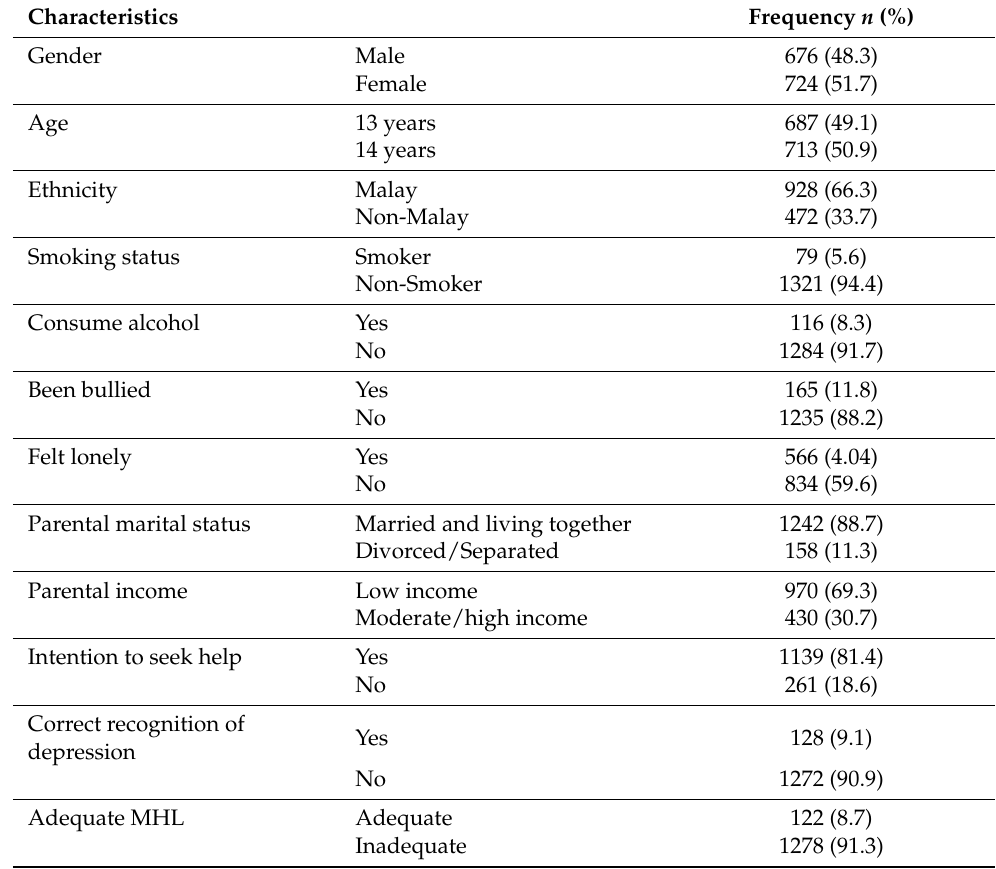
Table 1. Participant characteristics ( n =